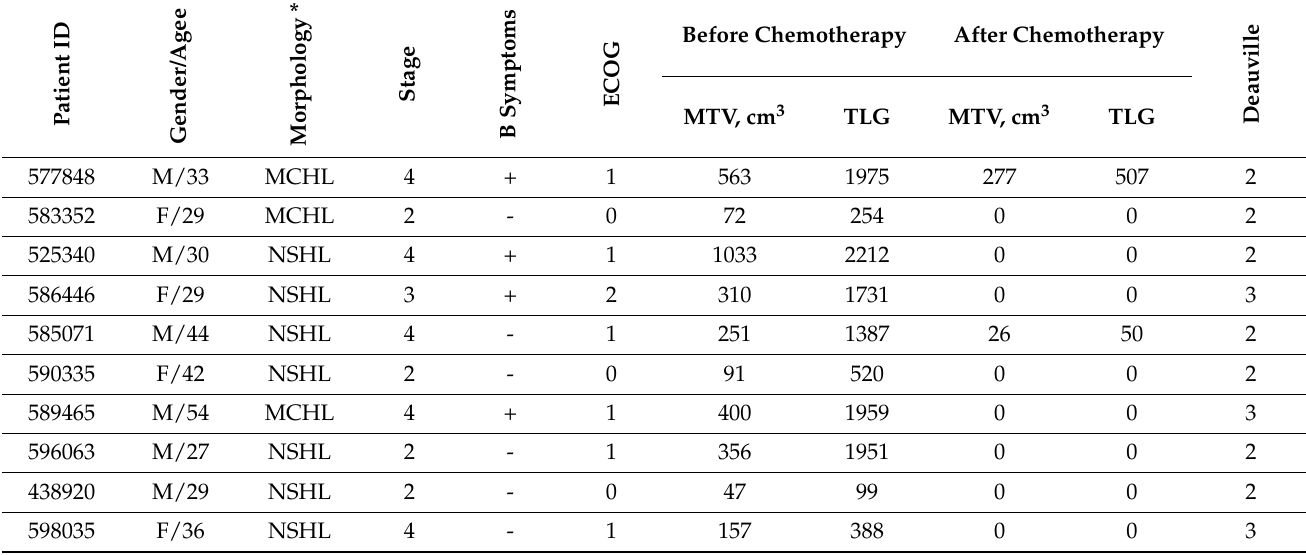
Table 1. Patients’